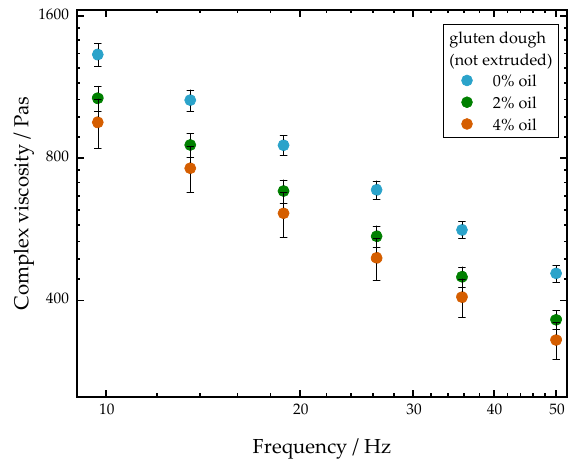
Figure 6. Influence of 0% oil (blue), 2% oil (green) and 4% oil (orange) on the complex viscosity of untreated gluten doughs (not extruded). Water content was 38–40%.